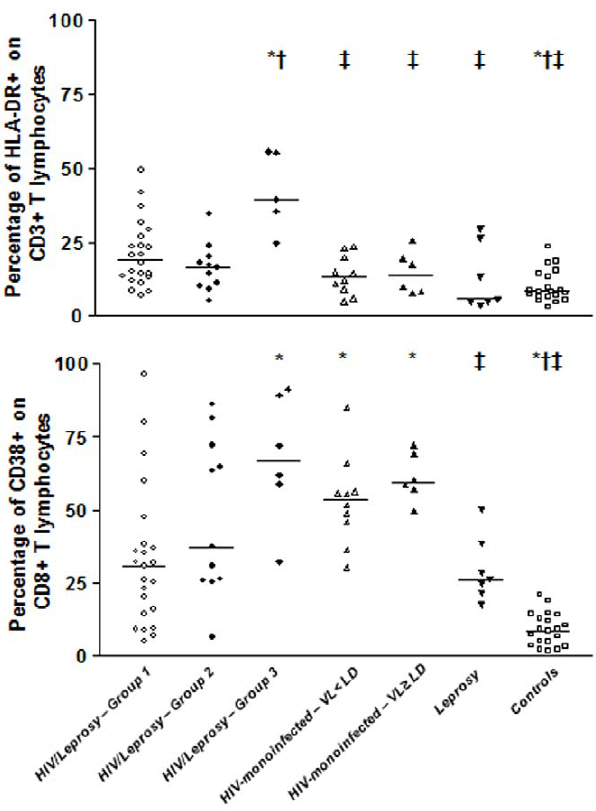
Figure 1. The percentage of HLA-DR + in CD3 + T lymphocytes ( upper panel ) and the percentage of CD38 + in CD8 + T lymphocytes ( lowerpanel ) in samples from HIV/leprosy patients from group 1 (VL , LD), group 2 (VL $ 80 , 10,000 copies/ml), and group 3 (VL $ 10,000 copies/ml); HIV-monoinfected VL , 80 copies/ml and VL . 80 copies/ml patients; leprosy-infected individuals; and healthy controls. Bars represent median values. * p , 0.05 – Mann-Whitney U test for each group compared with HIV/ leprosy patients from group 1; { p , 0.05 – Mann-Whitney U test for each group compared with HIV/leprosy patients from group 2; { p , 0.05 – Mann-Whitney U test for each group compared with HIV/ leprosy patients from group 3. VL: HIV viral load. LD: Limit of detection.